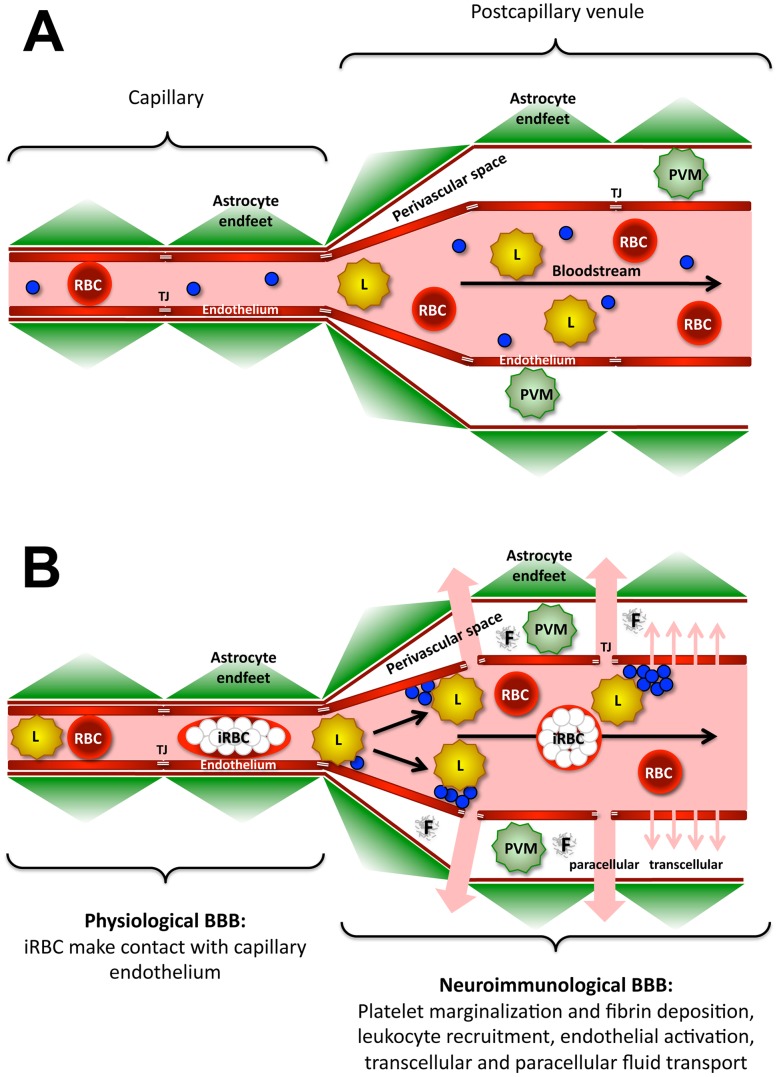
Model for the response of the two BBB to ECM.A) The cerebral microvascular tree contains two functionally distinct BBB. The physiological BBB is formed by capillaries (diameter 4–8 µm) and consists of a single layer composed of endothelia, gliovascular membrane, and astrocyte endfeet. The neuroimmunological BBB is formed by postcapillary venules (diameter 10–60 µm) and encompasses two layers that are separated by the perivascular space: 1) the endothelium with its basement membrane and 2) the glia limitans with associated astrocyte endfeet. While the physiological BBB serves as a diffusion barrier for solutes, the neuroimmunological BBB is characterized by higher permeability, which allows passage of macromolecules and diapedesis of immune cells into the perivascular space [69]. B) Although iRBC come into close contact with capillary endothelia, the physiological BBB remains intact during ECM. iRBC do not bind to the wall of PCV, but platelet marginalization and leukocyte recruitment indicate that PCV endothelia become activated in response to the infection. Leukocyte adhesion to and crawling along the endothelium involve LFA-1/ICAM-1 mediated cellular interactions. Eventually, the neuroimmunological BBB opens, initially in a reversible fashion, thus allowing the leakage of plasma into the PVS. The fluid transport is regulated and occurs via paracellular-junctional (large arrows) and/or transendothelial-vesicular (small arrows) pathways in the absence of cell death. PVM = perivascular macrophage, L = leukocyte, blue circles = platelets.